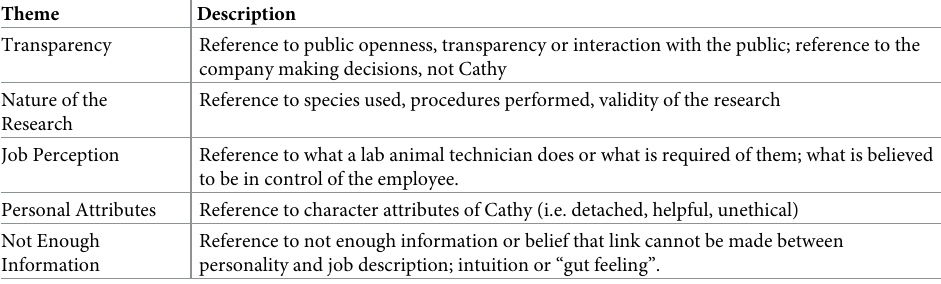
Table 4. Themes coded for qualitative responses to perception of lab animal technicians in high and low transpar- ency